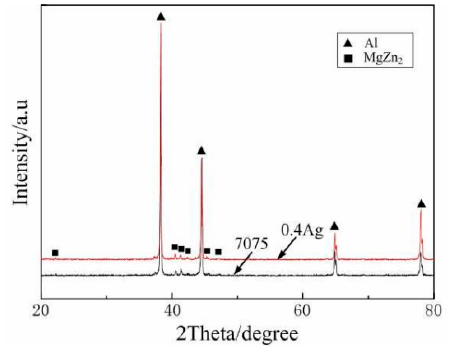
Figure 1. XRD pattern of as-cast 7075 (0 Ag) alloy and 0.4 Ag alloy. Adapted with permission from ref. [34]. 2015